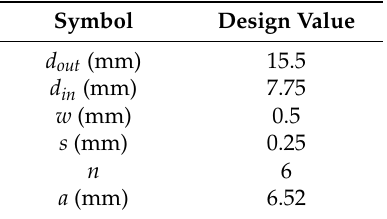
Table 1. Parameters of the designed LC pressure